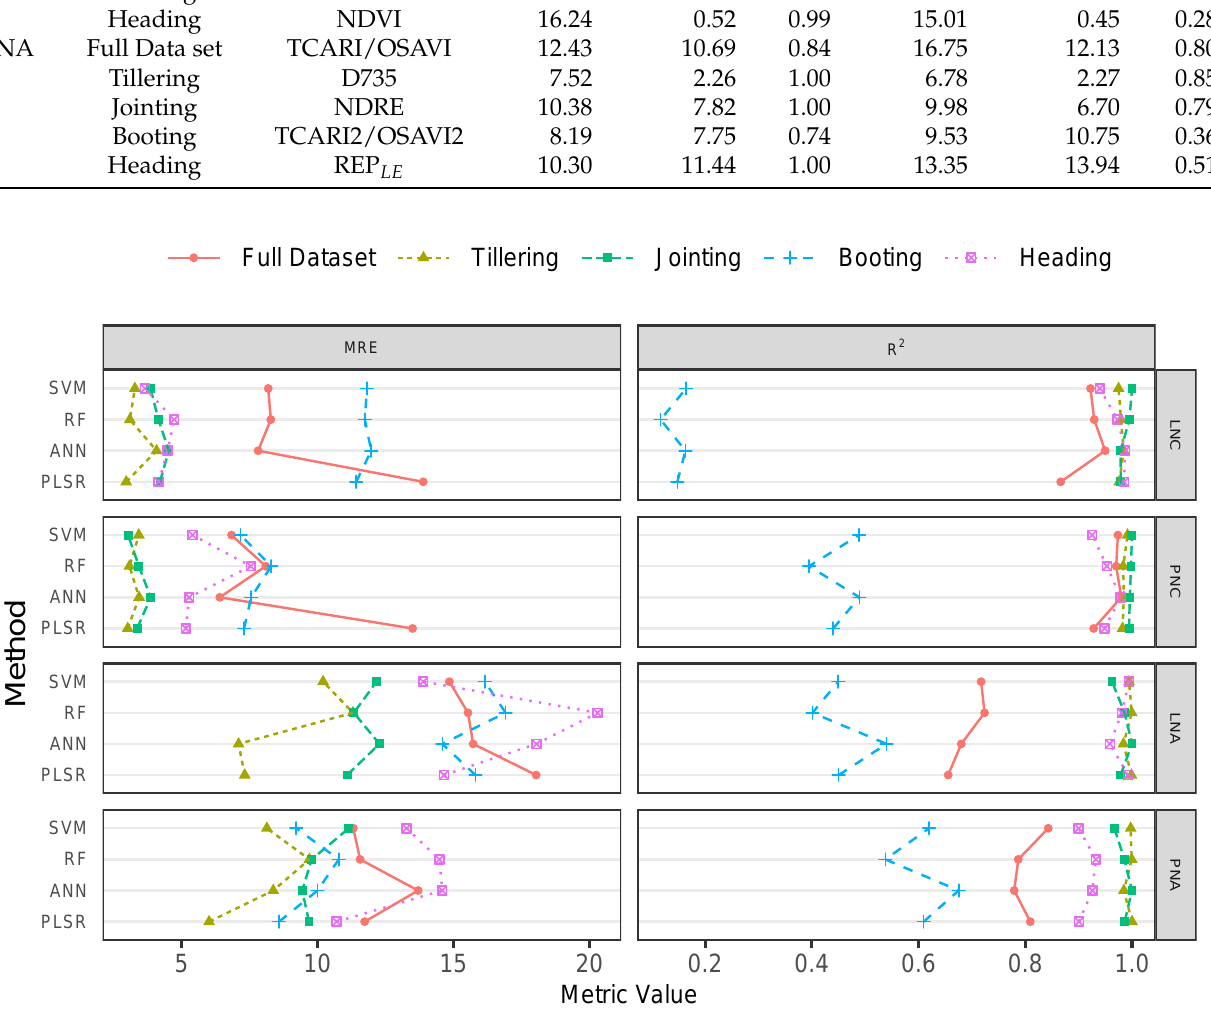
Figure 6. Growth-stage-specific and full-growth-stage cross-validated MRE and R 2 values of the PLSR, ANN, RF and SVM for LNC, PNC, LNA and PNA